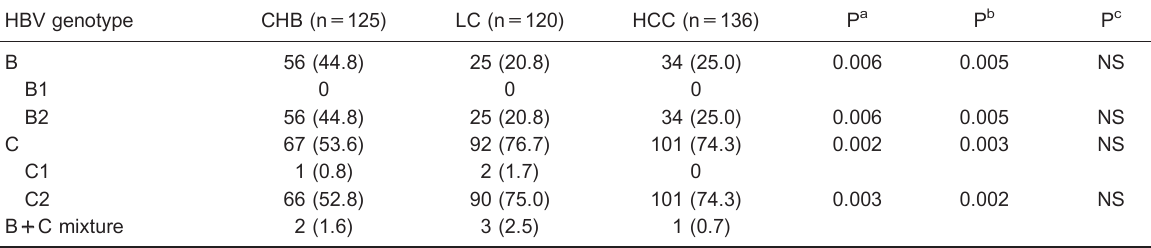
Table 1. HBV genotype frequency distributions in 381 patients with chronic HBV infection. HBV